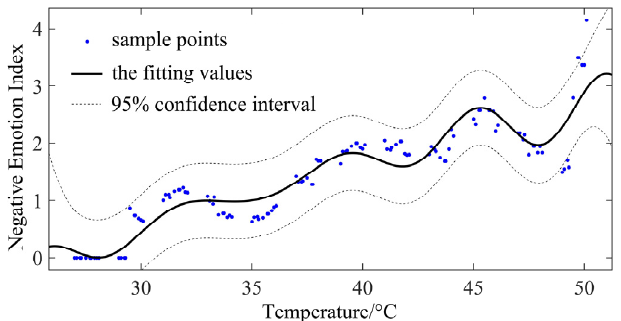
Figure 3. Model of temperature value and negative emotion index.